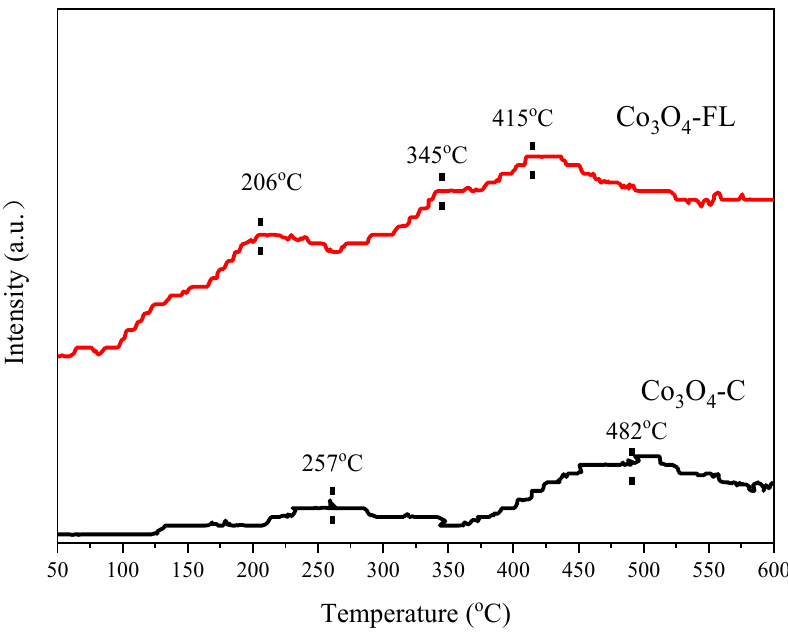
Figure 4. O 2 -TPD profiles of the Co 3 O 4 -FL and Co 3 O 4 -C catalysts. The spectra of Co 2p and O 1s are displayed in Figure 5a,b, illustrating the chemical surface compositions and valence states. The BE value of Co 2p 3/2 is 779–780 eV, and a 2p 1/2 splitting of 15 eV is characteristic of the octahedral Co 3+ component of Co 3 O 4 [19]. The satellite peaks at 785 eV evidence the existence of Co 2+ species in the octahedral sites [20,21]. Here, the Co 2p spectra were resolved using a fitting procedure partially based on that suggested by Biesinger et al. [22]. The contributions of the Co 3+ and Co 2+ cations can be identified at 779.5 and 781.1 eV, respectively [23]. Additionally, two satellite peaks, S 1 and S 2 , at 785.3 and 789.4 eV, appeared due to electron correlations and the final state effects in the Co 2+ and Co 3+ cations, respectively [24]. Meanwhile, the satellite peak S 3 indicates the spin orbit contributions of Co 2p 1/2 , as do the satellites S 1 and S 2 [25,26]. The O 1s spectra in Figure 5b are also decomposed into two peaks. The peaks located at 529.7 and 531.2 eV can be ascribed to lattice oxygen (O latt , i.e., O 2- ) and oxygen adsorbed onto the surface oxygen vacancies (O sur , i.e., O − , O 22 − , and OH − ), respectively [27].